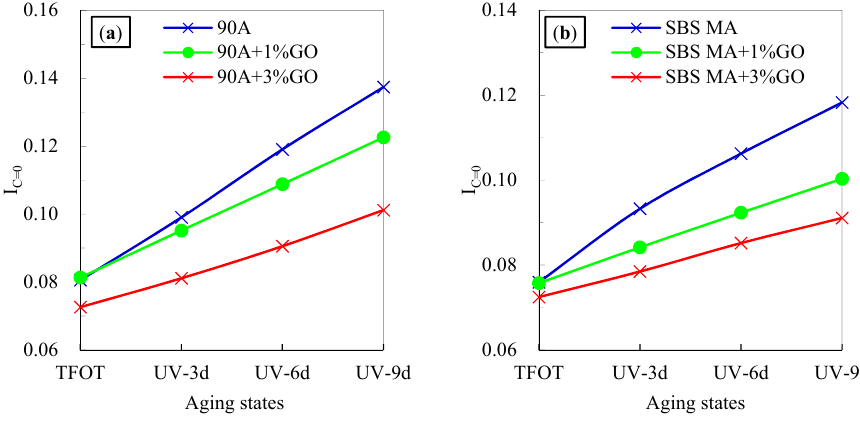
Figure 2. The I C=O of 90 A ( a ) and SBS MA ( b ) after UV aging.